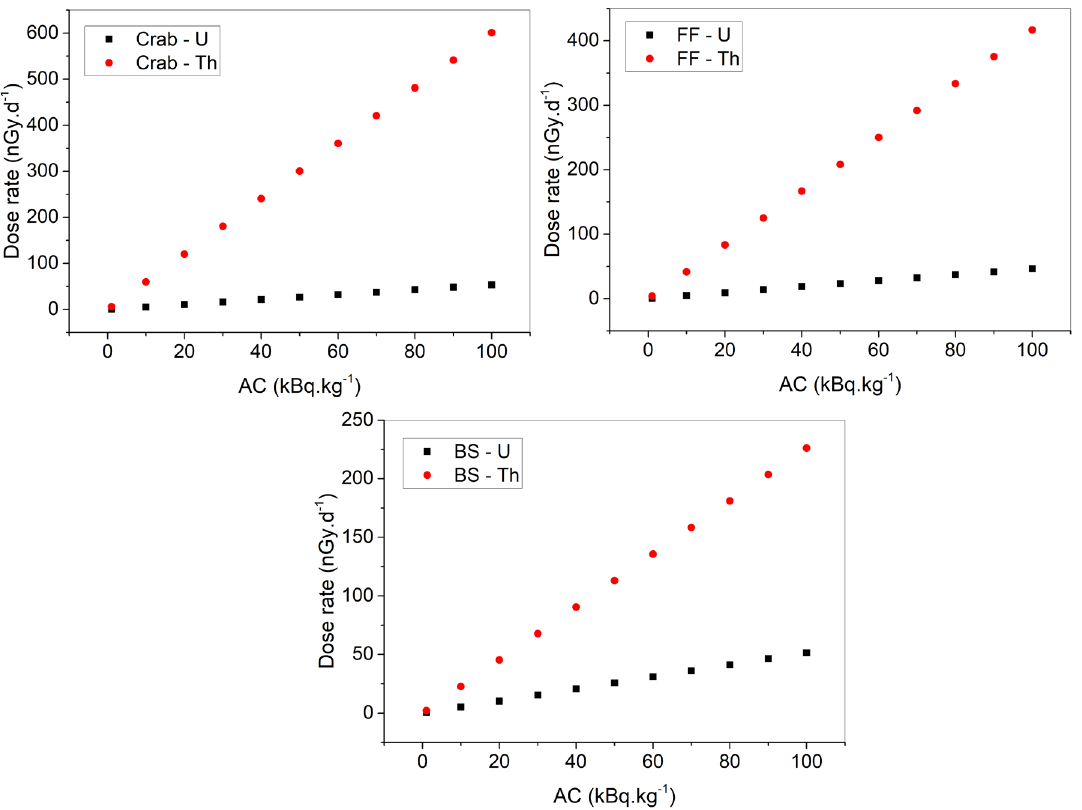
Figure 5. Total D due to uranium and thorium series for each organism in function of the AC. R